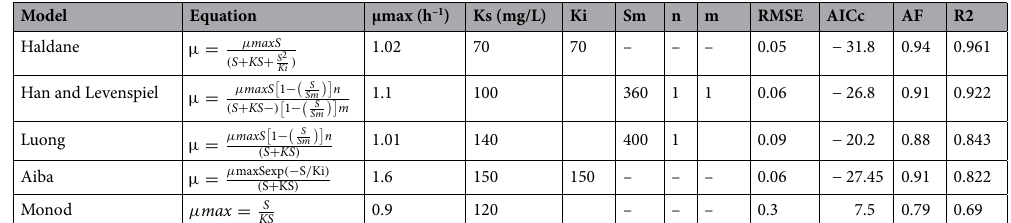
Table 9. Various kinetic models for effect of substrate on growth